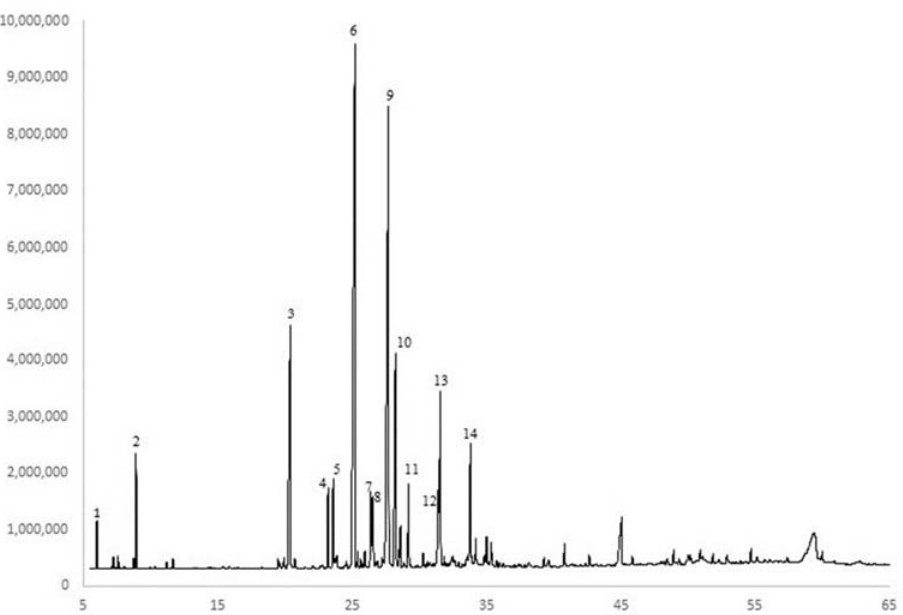
Figure 7. GC ‐ FID chromatogram of a representative M. friwaldskyanum essential oil with major con